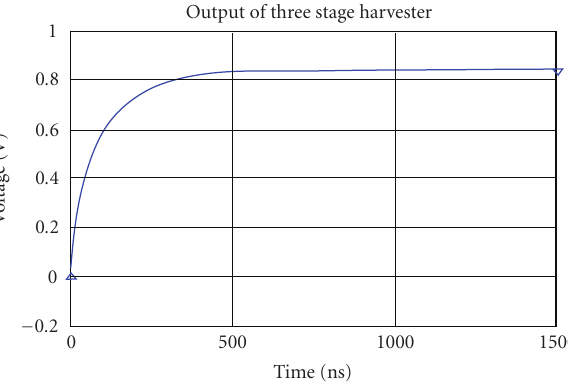
Figure 12: Three-stage harvester’s output